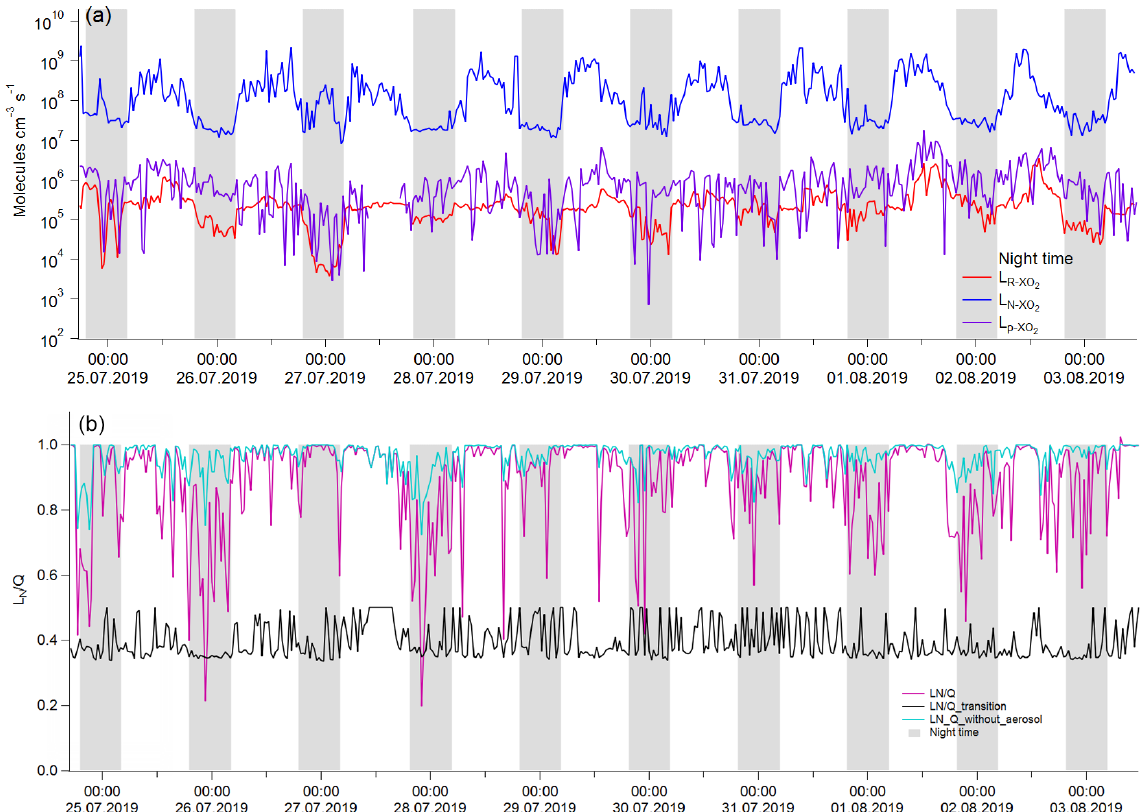
Figure 5. Temporal variations in (a) HO 2 radical loss rates and (b) L N /Q (red line) and the regime transition threshold ( L N /Q _transition, black line) used to assess the ozone sensitivity regime. The gray shaded areas represent nighttime (from the National Astronomical Observa- tory of Japan) and are not discussed